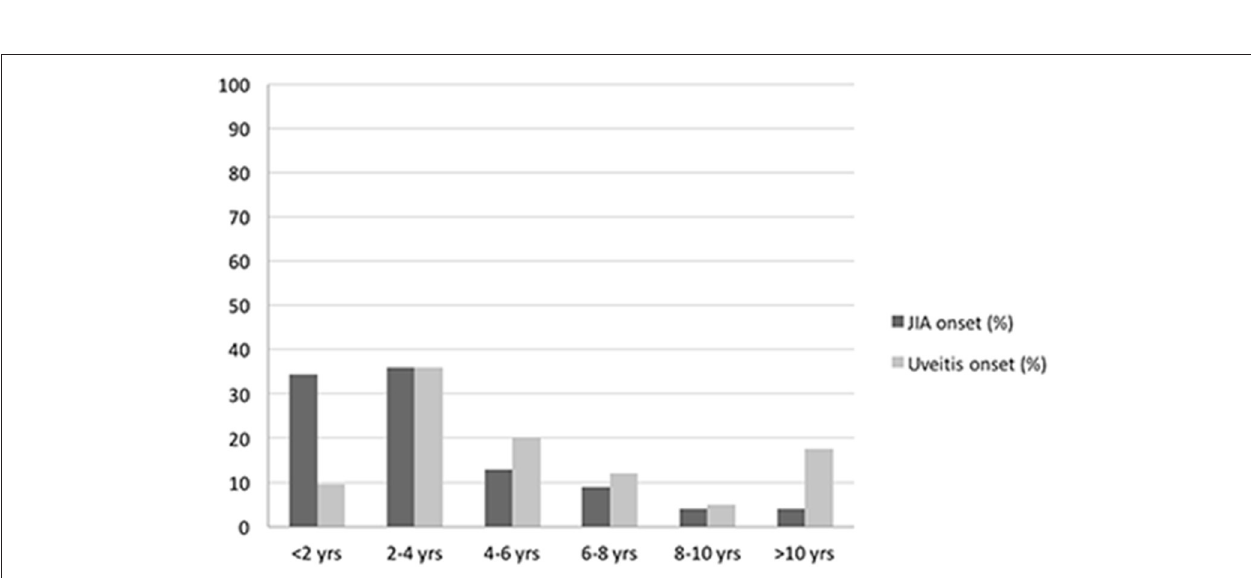
FIGURE 2 | Bar graph showing age distributions of patients at diagnosis of JIA and uveitis.